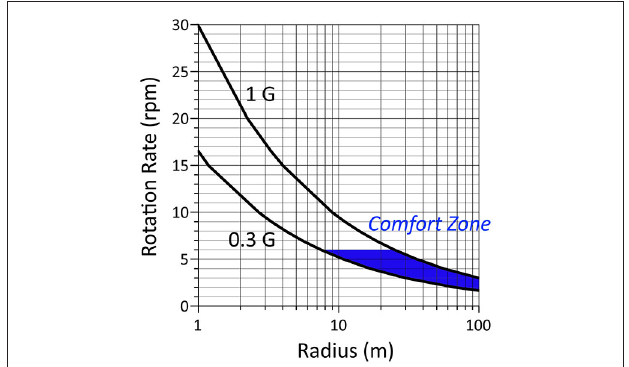
FIGURE 2 | Hypothetical comfort zone bounded by values of artificial gravity level and rotation rate based on theoretical studies in the 1960s (see Hall, 2009, for details) . The “comfort zone” is the area in blue delimited by a maximum rotation rate of 6 rpm. According to the model of Stone and Letko (1965) the Coriolis and cross-coupled angular accelerations generated at these rotation rates during walking, climbing and handling materials should be the most comfortable for the crewmembers. However, very little experimental data were actually collected to validate this model. Recent data indicate that the limit of 6 rpm is overly